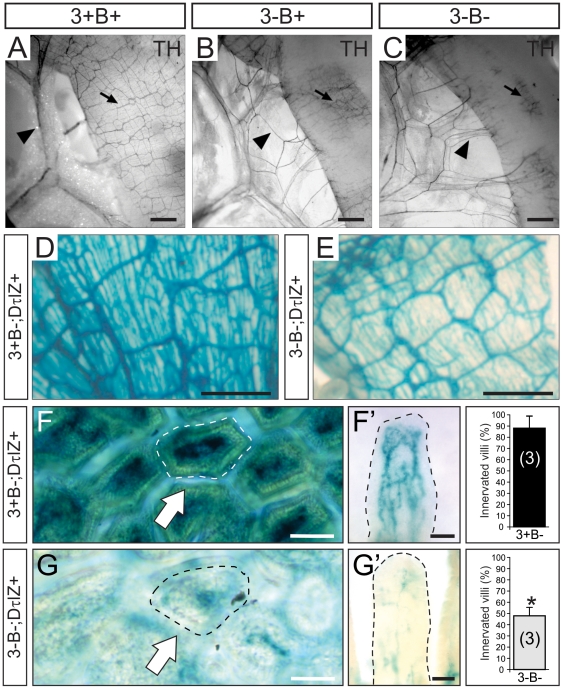
Abnormal sympathetic innervation to small bowel in the absence of Egr3 and sympathetic neuron death.(A) in wild type (3+B+) mice, tyrosine hydroxylase (TH) immunohistochemistry performed on vascularized intact small bowel demonstrated sympathetic axons coursing along the mesenteric blood vessels (arrowhead) and prominent intercrossing pattern of TH+ fibers in the bowel wall (arrow). (B, C) In preparations from mice lacking Egr3, with (3-B+) our without Bax (3-B−), the TH+ axons were noted to prematurely defasciculate from the mesenteric blood vessels prior to innervating the bowel wall (arrowhead) and the pattern of intercrossing TH+ fibers in the bowel wall was highly attenuated (arrow) (4 week old mice shown). (D, E) The attenuated mural innervation was confirmed using DτlZ sympathetic reporter mice which showed a highly attenuated innervation of the bowel wall in 3-B− relative to 3+B− mice. (F) Sympathetic innervation to the small bowel mucosa was observed in the vascular core of mucosal villi from control (3+B−; DτlZ+) sympathetic reporter mice (arrow, villi shown in whole mount preparation in the axial plane). (F') Sympathetic innervation within the small bowel villi paralleled the vascular capillary network (villus shown in whole mount preparation in the longitudinal plane). (G) In Egr3-deficient mice with inhibited sympathetic neuron death (3-B−; DτlZ+) <45% of the villi were innervated (arrow) and (G') most villi that did have some innervation showed a highly attenuated abnormal innervation pattern. (quantitative results represent the mean ± standard error of >500 villi scored; * = p<0.01, Student's t test compared to 3+B−; DτlZ+ control mice; scale bar = 50 µm; number of 4–8 week old animals analyzed indicated in parentheses).